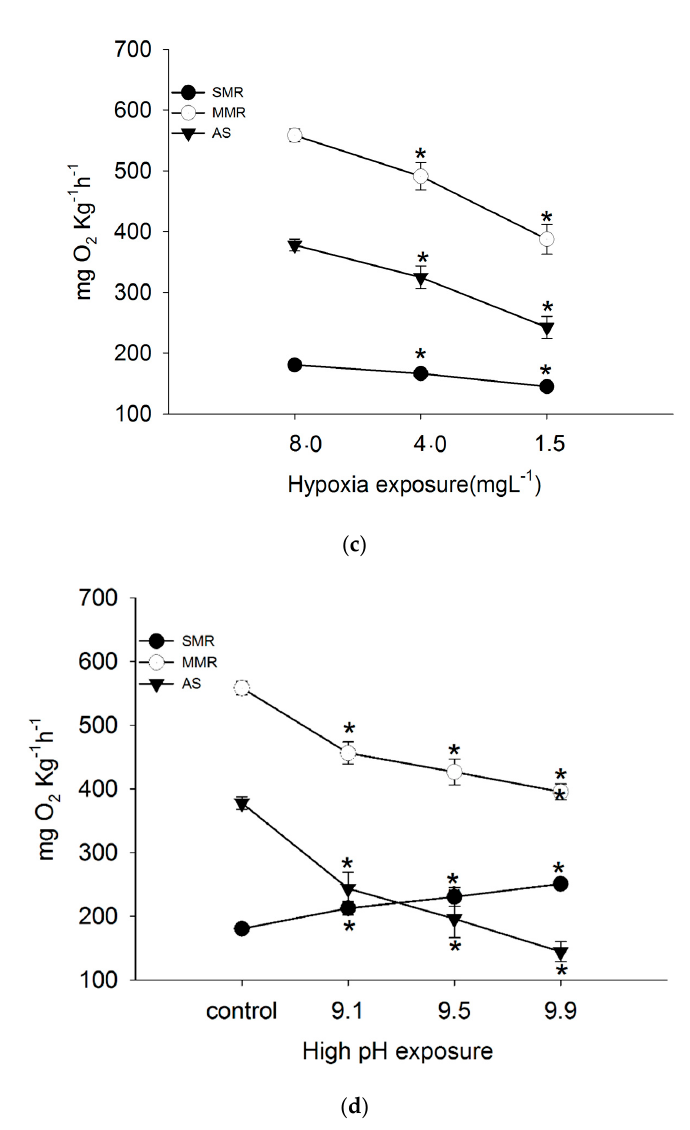
Figure 1. Standard metabolic rate (SMR), maximum metabolic rate (MMR), and aerobic scope (AS) of Carassius auratus gibelio exposed to high ammonia (control, 0.5 mg L − 1 , 1.0 mg L − 1 , 2.0 mg L − 1 ) ( a ), high nitrite (control, 0.5 mg L − 1 , 1.0 mg L − 1 , 1.5 mg L − 1 ) ( b ), hypoxia (control, 4.0 mg L − 1 , 1.5 mg L − 1 ) ( c ), and high pH (control, 9.1, 9.5, 9.9) ( d ). Values are means ± SE. Statistically significant difference among treatments at each time point (“*”shows the significant different from control) were revealed by a one-way ANOVA test, followed by multiple comparisons with the Holm–Sidak method ( P ≤ 0.05).